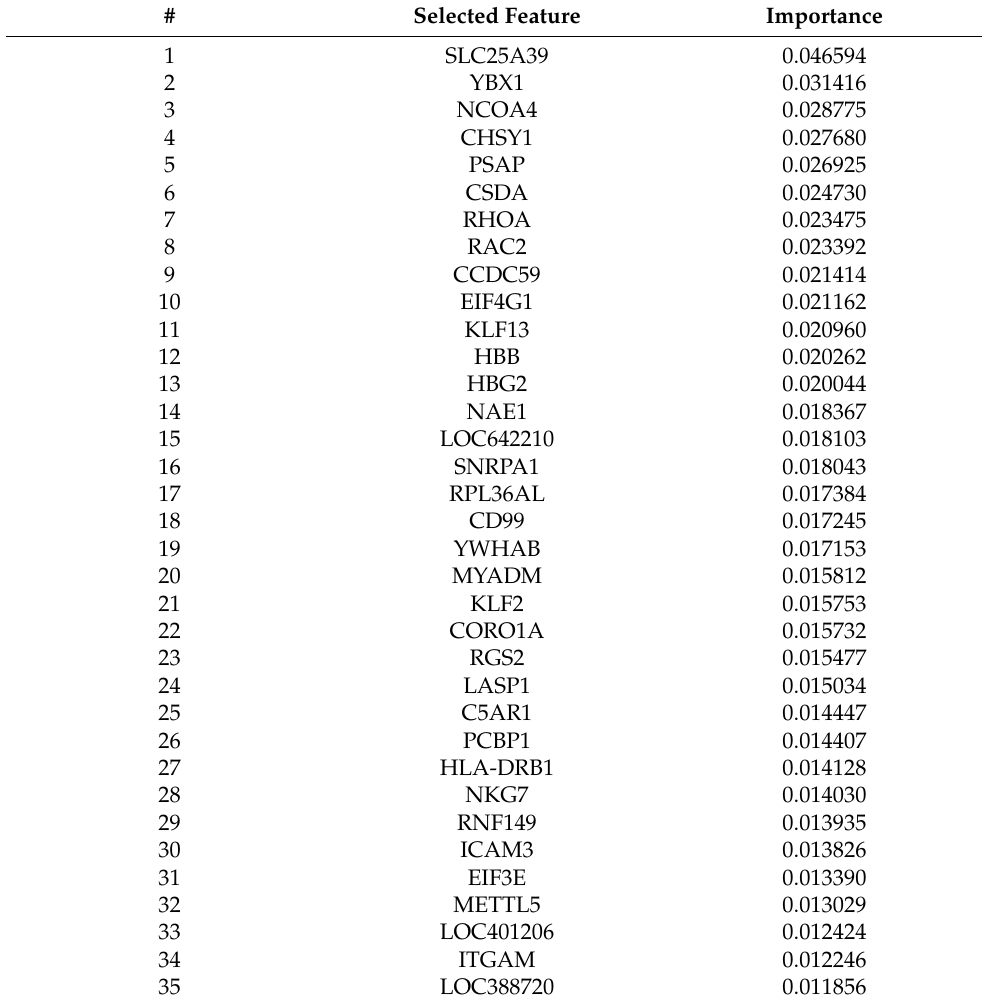
Table 1. Features selected by RFE with five-fold cross-validation.